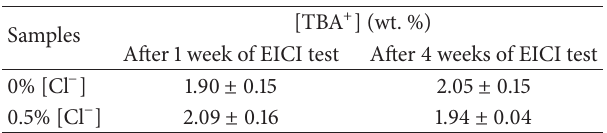
Table2:[TBA + ]contentbytimeofEICItreatmentinsodiumborate solution.